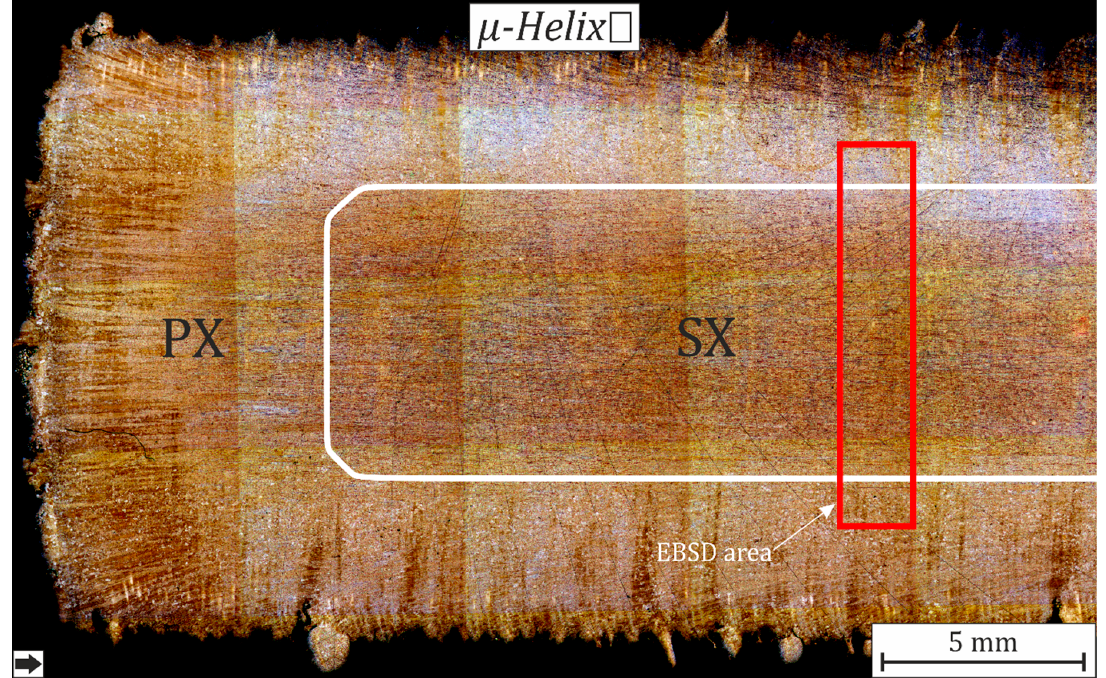
Figure 5. Macro-etched longitudinal section of a cuboid sample manufactured with the µ-Helix parameter setting. The build direction is indicated by the black arrows. A high quality SX region is present in the center of the sample. For convenience, the SX region (white), as well as the areas for the EBSD measurements are highlighted (red).